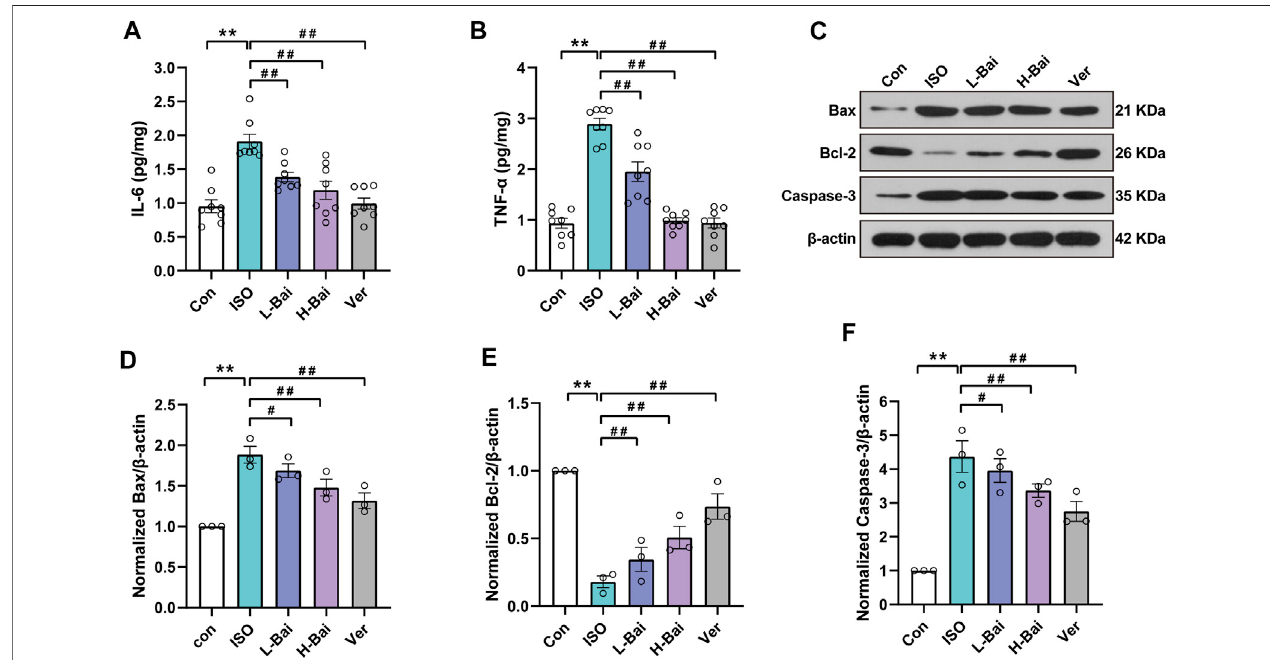
FIGURE5| EffectsofBaioninterleukin6,tumournecrosisfactoralpha(IL-6,TNF- α ),Bcl-associatedXprotein,B-celllymphoma2(BaxandBcl-2,respectively)and Caspase-3 in mouse myocardium. (A,B) IL-6 and TNF- α levels were measured by enzyme-linked immunosorbent assay (ELISA). (C) Western blotting was applied to measuretheproteinexpressionsofBax,Bcl-2,andCaspase-3. (D-F) RelativeintensitiesofBax,Bcl-2,andCaspase-3werenormalizedto β -actin.Valuesarepresented as means ± S.E.M. p < 0.01 versus Con; p < 0.01, p < 0.05 versus ISO.